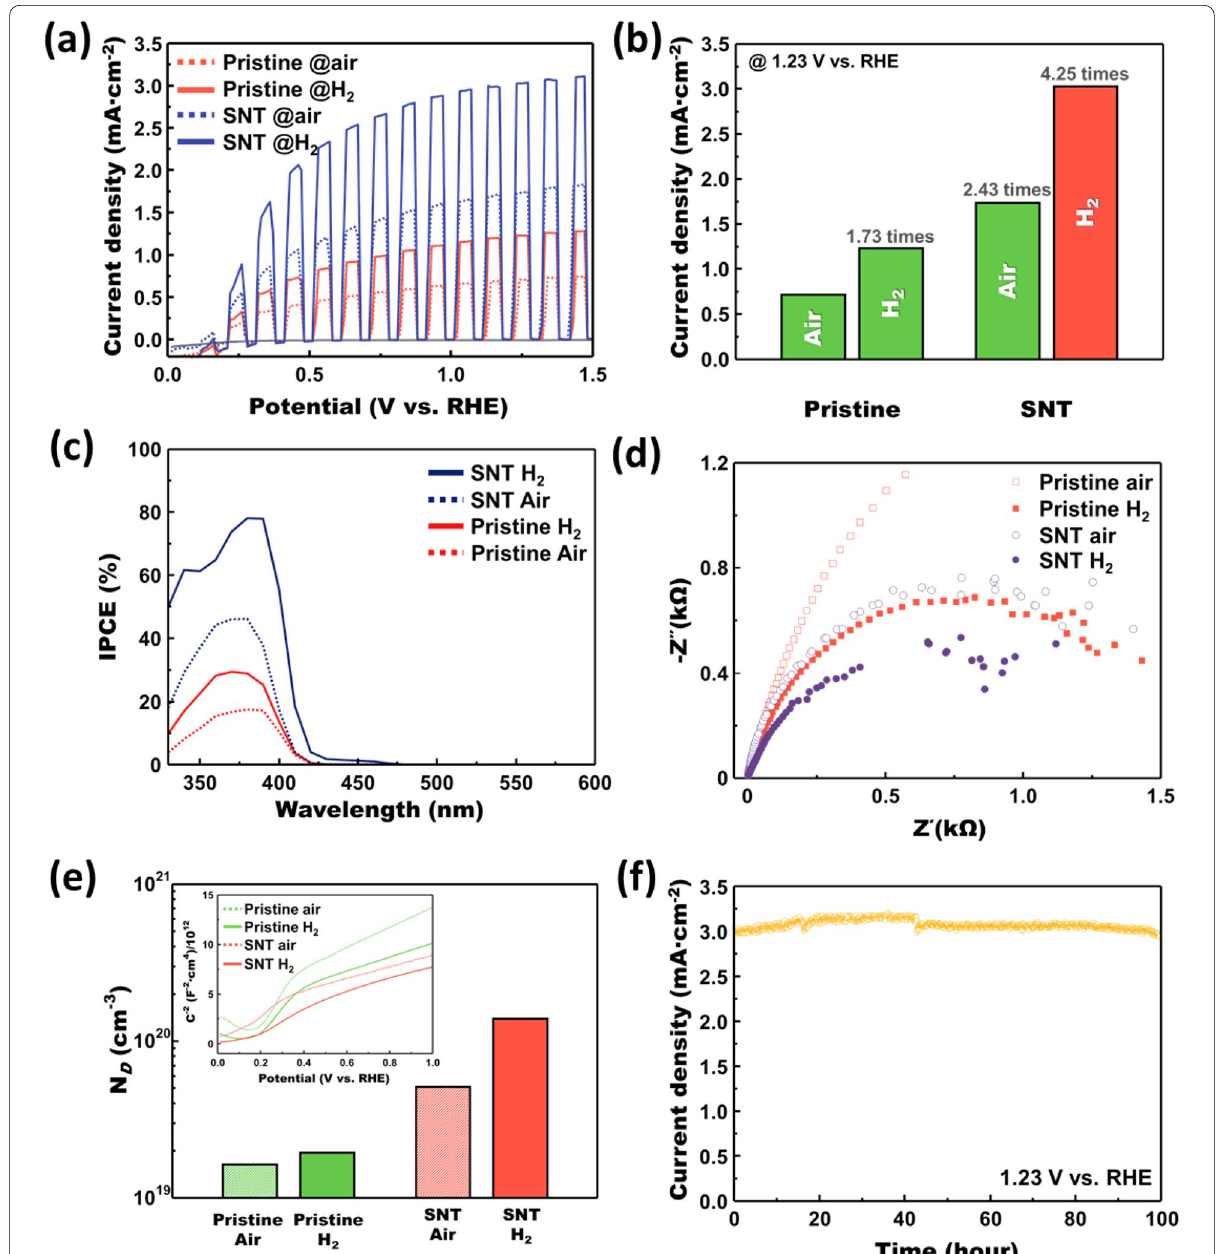
Fig. 8 Determination of the photoelectrochemical properties. a Linear Sweep Voltammetry curves of the optimum and reference samples. b Comparison charge of the photocurrent density under the 1.23 V vs. RHE condition. c Results of incident photon-to-current efficiency measurement under 1.23 V vs. RHE condition. d Nyquist plots, obtained by electrochemical impedance spectroscopy, showing the charge transfer resistance of each sample. e Plot of the carrier concentration calculated by fitting the Mott-Schottky plots of each sample. Mott-Schottky plots of each sample also displayed as the inset image. f Chronoamperometric measurement at 1.23 V vs. RHE for 100